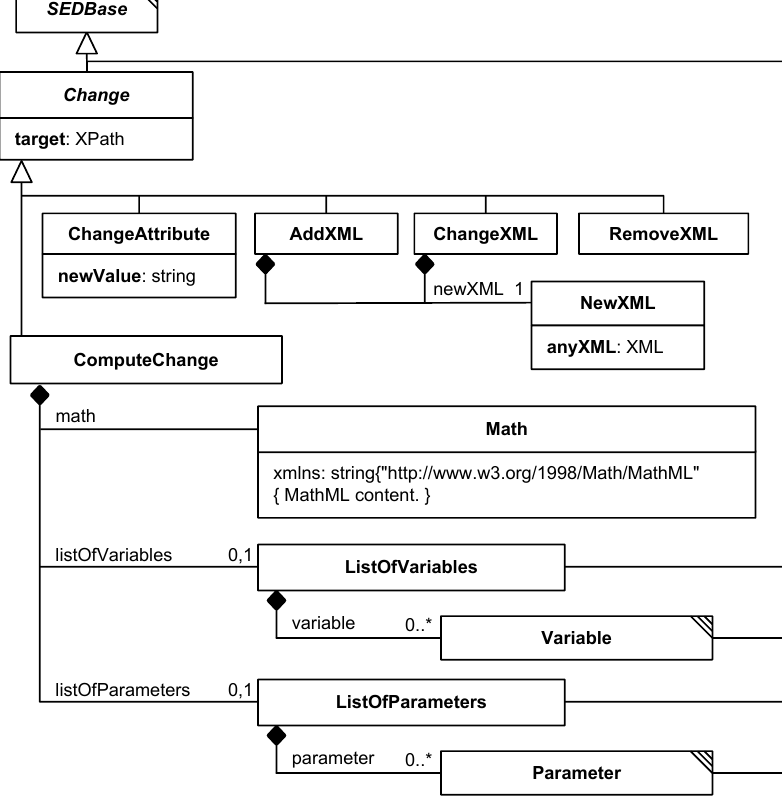
Figure 2.10: The SED-ML Change class